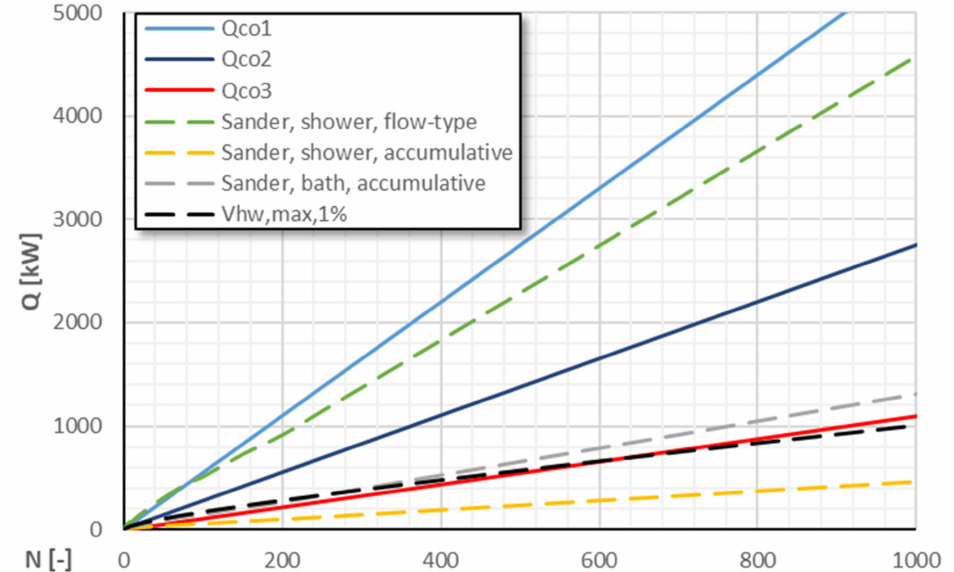
Figure 6. Heat source peak power for heating the buildings in different insulation standards and for preparing the hot water—comparison for N